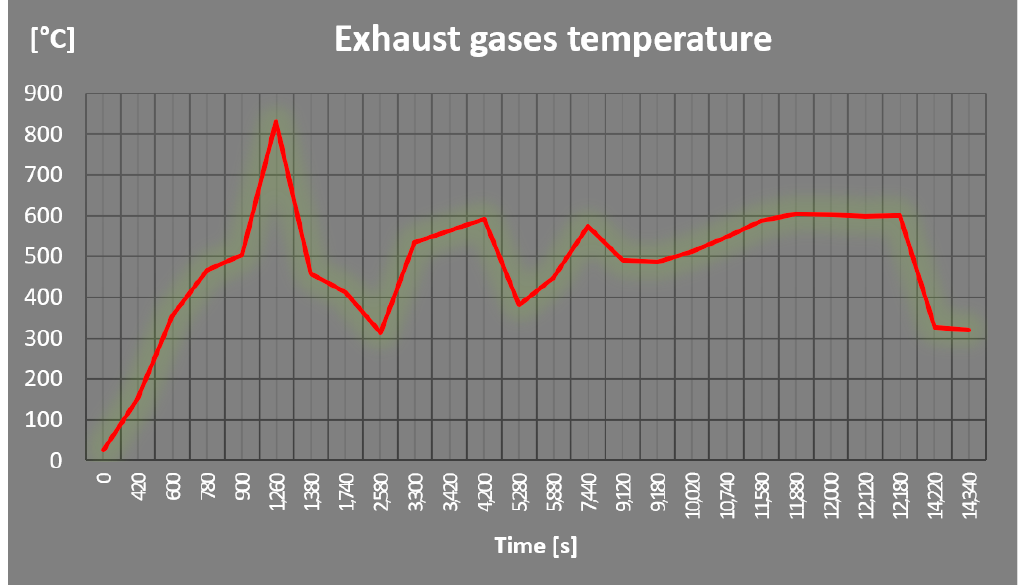
Figure 4. The temperature of the exhaust gases.